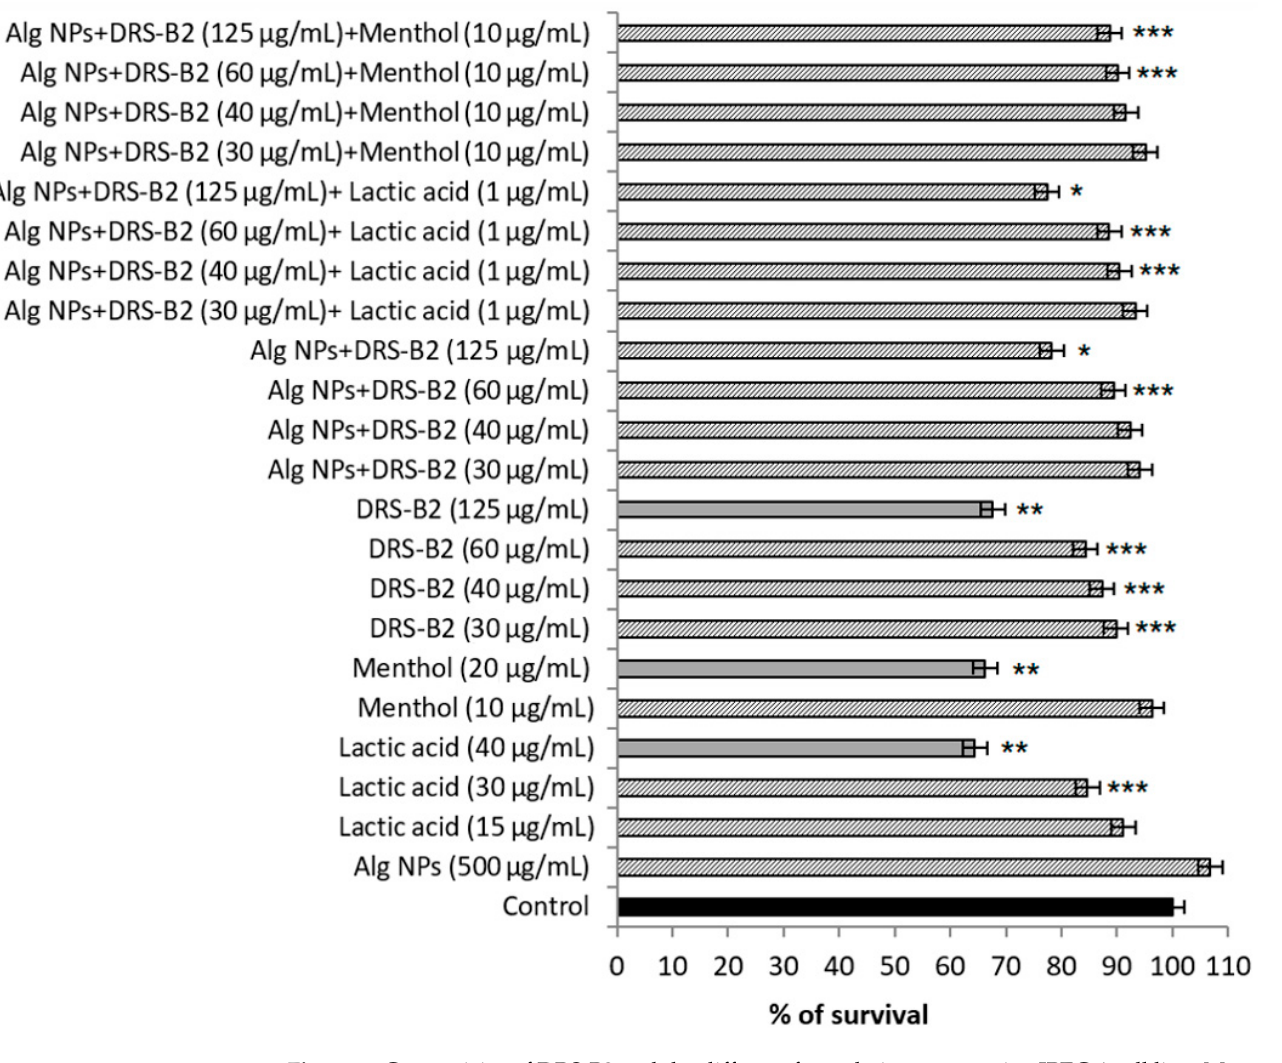
Figure 2. Cytotoxicity of DRS-B2 and the different formulations on porcine IPEC-1 cell line. Means with ( * ), ( ** ), or ( *** ) are significantly different from control and between them ( p < 0.05).